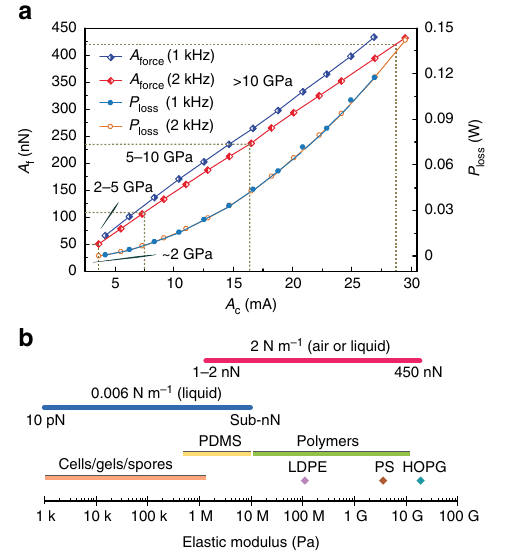
Fig. 2 Magnetic drive strength and modulus range of the NM technique. a Calibrated magnetic drive force ( A f ) and P loss when the probe was oscillated at 1 and 2 kHz with different drive currents ( A c ). b Elastic moduli of various common matter ranges from 1 kPa to 20 GPa are uni fi ed into two modulus spectra using only two probes with spring constants of 0.006 N m − 1 and 2 N m −